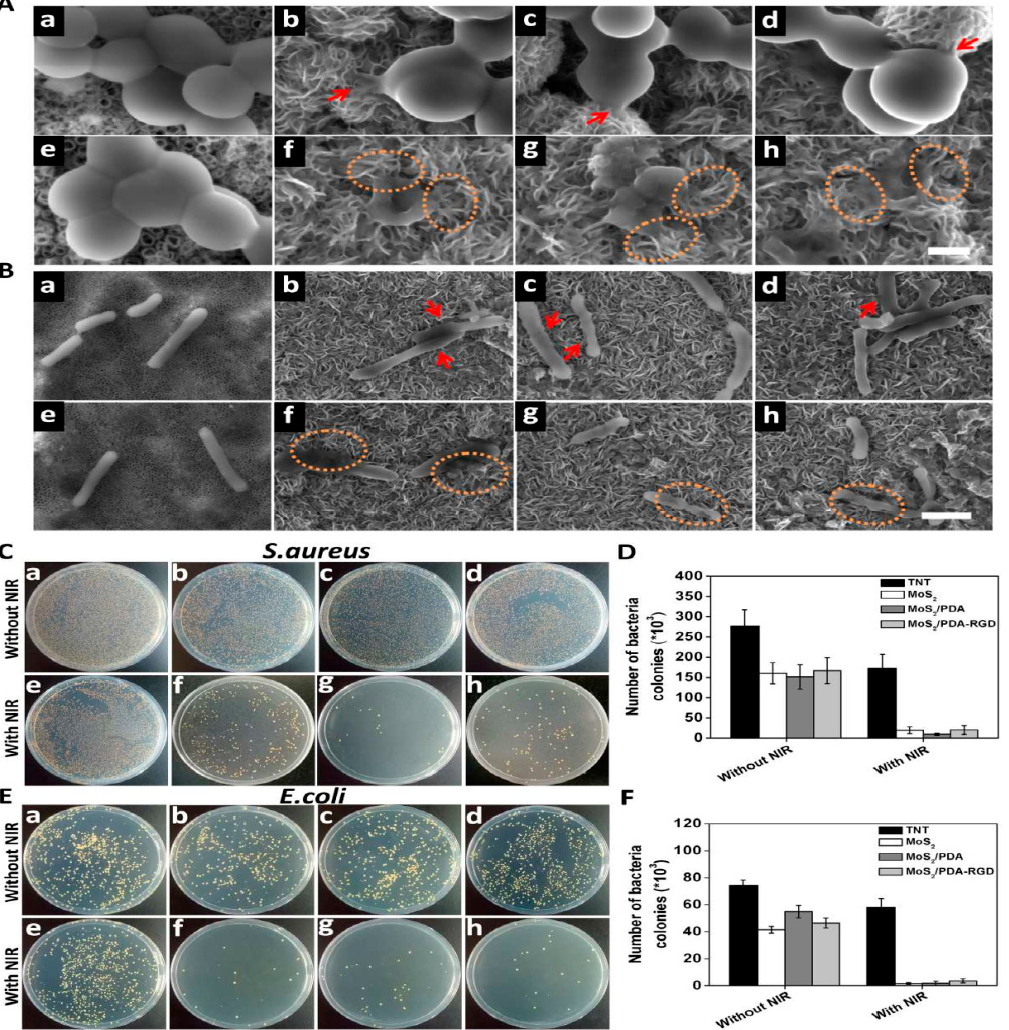
Figure 6. SEM and photographic images of the antibacterial activity of MoS 2 –PDA–RGD, ( A ) SEM images of S. aureus and ( B ) SEM images of E. coli , ( C , D ) photograph and number of colonies of S. aureus and ( E , F ) photograph and number of colonies of E. coli . ( a ) TNT, ( b ) MoS 2 , ( c ) MoS 2 -PDA, ( d ) MoS 2 -PDA-RGD, ( e ) TNT/NIR, ( f ) MoS 2 /NIR, ( g ) MoS 2 /PDA/NIR and ( h ) MoS 2 -PDA-RGD-NIR. The image was taken with permission [86] .